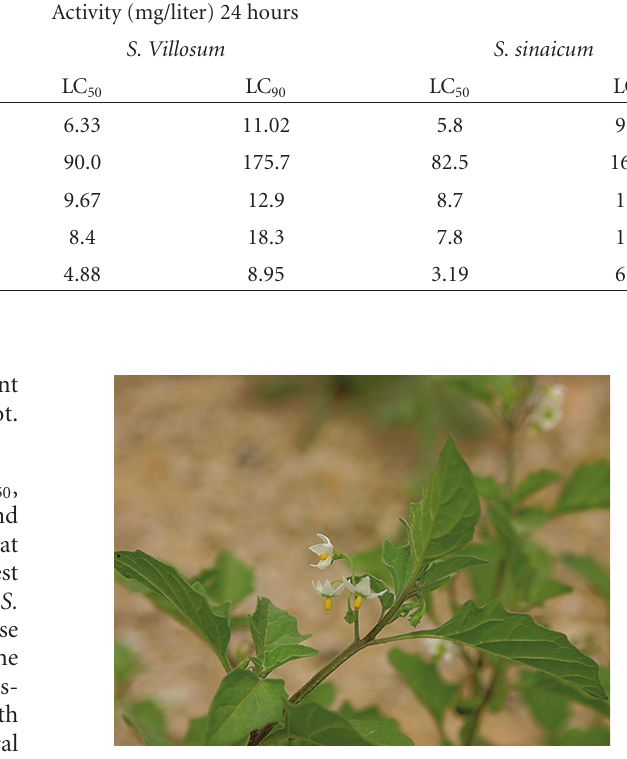
Figure 1: S. nigrum